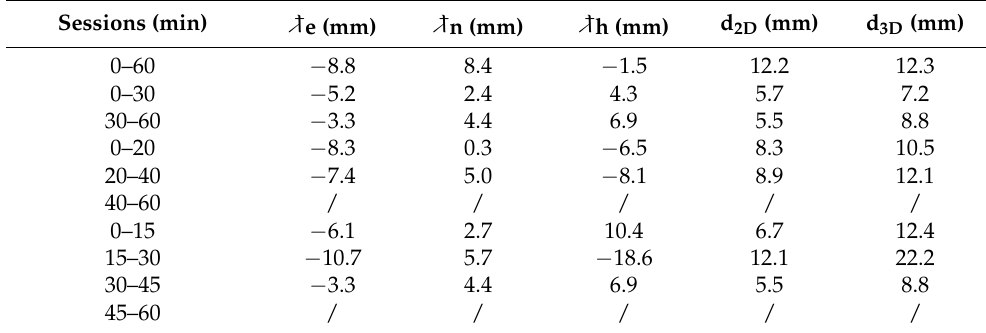
Table 1. Used parameters in the data processing.